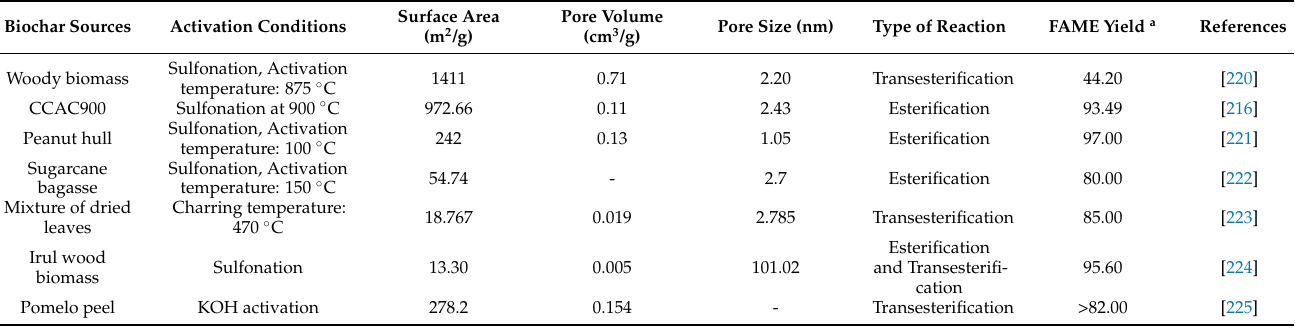
Table 3. Different type of biomass-based